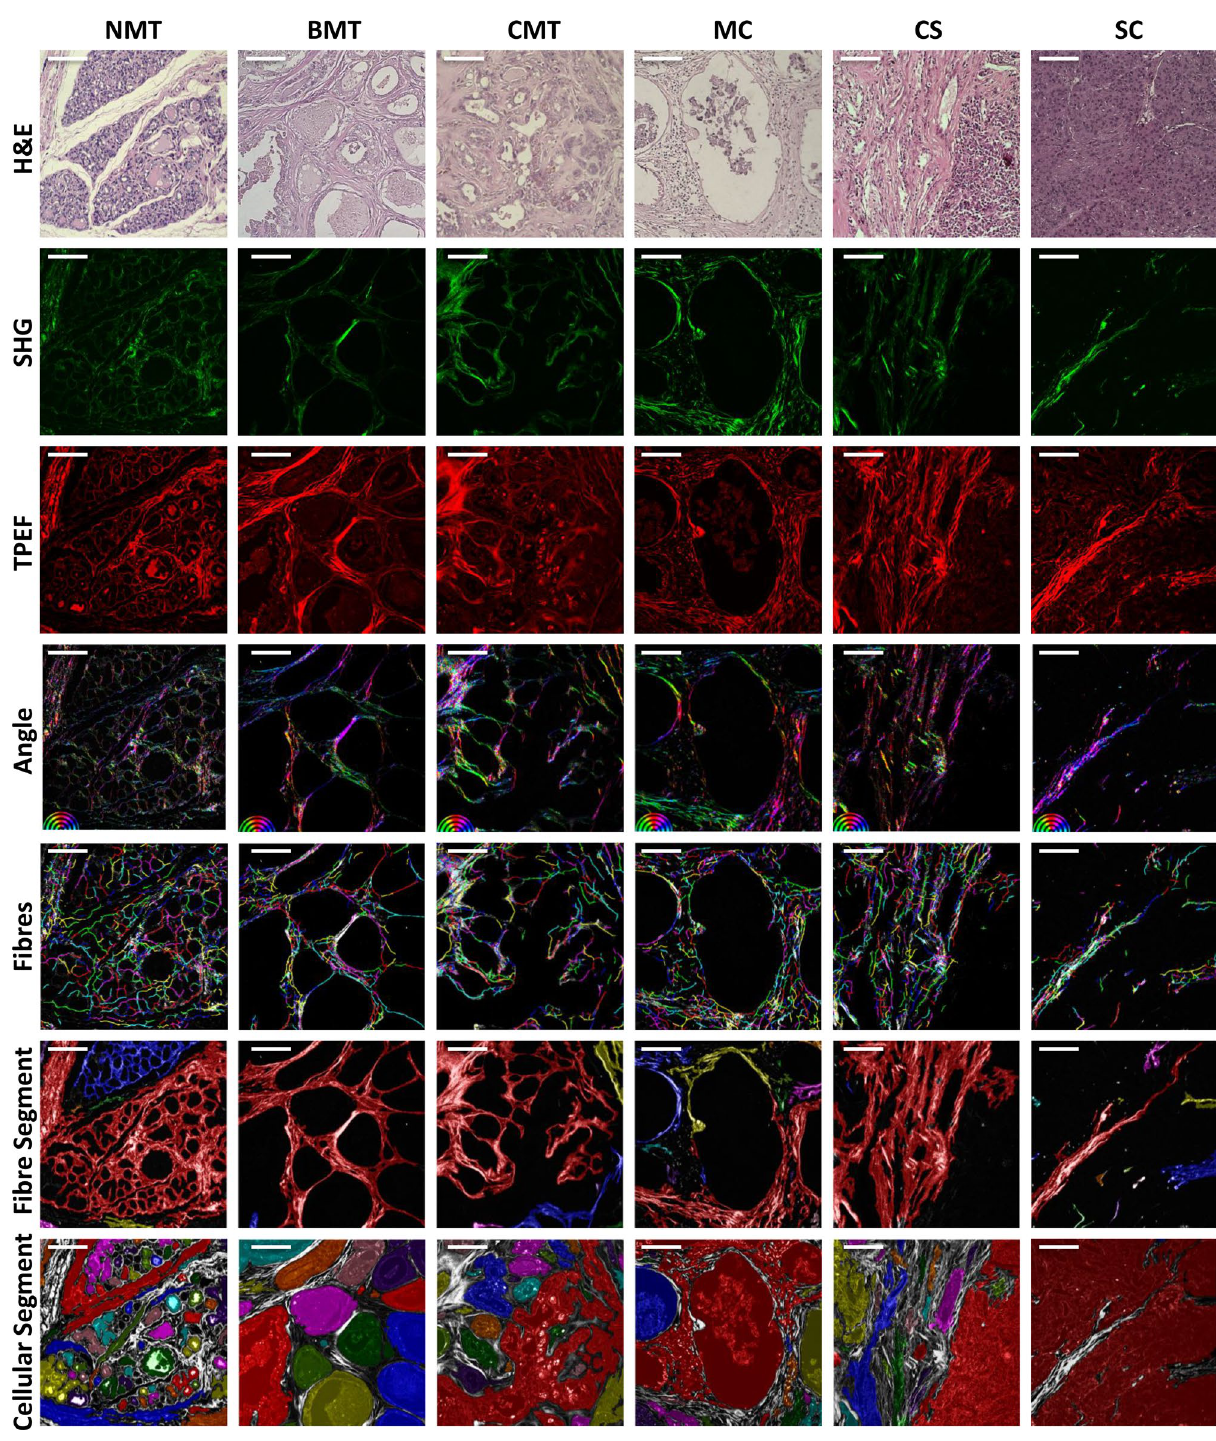
Figure 1. Acquired images: the optical microscopy H&E (first row), SHG (second row), TPEF (third row) and the images extracted by the software: a colour map image with the angle distribution of the collagen fibre orientation in the tissue (fourth row, angle colour map at the bottom left hand side), the extracted collagen fibres with each fiber in a random colour (fifth row), the fibre segment (sixth row) and the cellular segments (seventh row) for the histological types in the columns NMT, BMT, CMT, MC, CS, SC. Each connected fibre and cellular segment is presented in a random colour. The scale bar is 100 µ